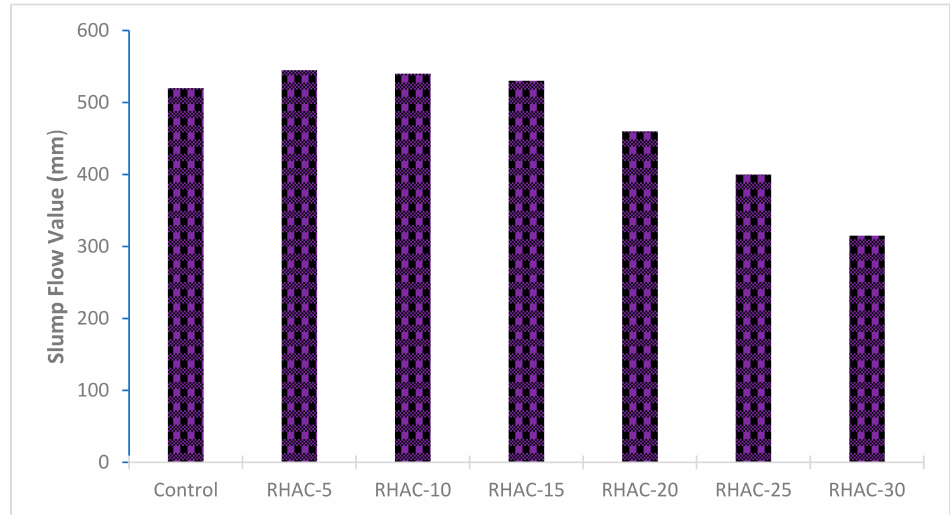
Figure 9. Slump flow of HPC made with different contents of